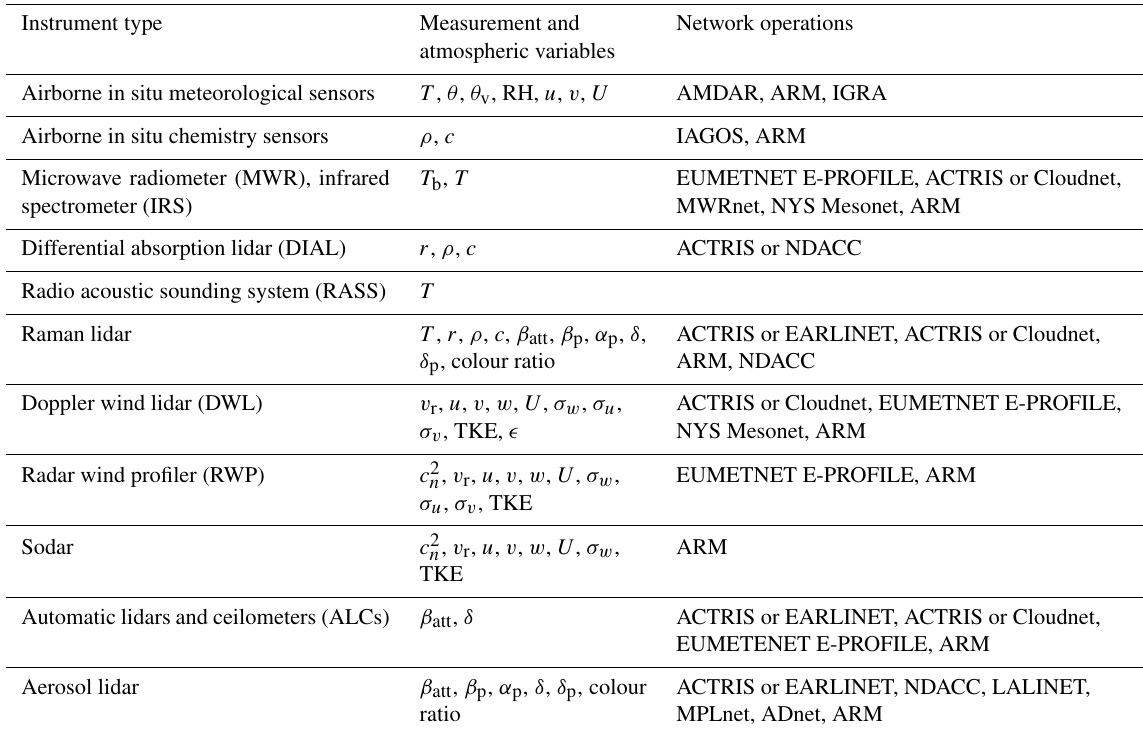
Table 2. Instrument types used to gather vertical profiles of atmospheric and measurement variables (Sect. 2.1; Table 1) in the atmospheric boundary layer. These observations are increasingly organised in national and international monitoring networks (see Sect. 2.3 for further de- tails). Abbreviations: ACTRIS (Aerosols, Clouds and Trace gases Research Infrastructure), ADnet (Asian Dust and aerosol lidar observation network), AMDAR (Aircraft Meteorological Data Relay), ARM (Atmospheric Radiation Measurement), EARLINET (European Aerosol Research Lidar Network), EUMETNET E-PROFILE (European Profile of the European Meteorological Network), IAGOS (In-service Air- craft for a Global Observing System), IGRA (Integrated Global Radiosonde Archive), LALINET (Latin America Lidar Network),